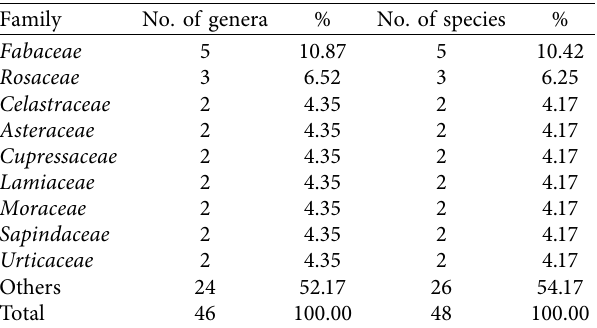
Table 1: Top nine families with the number of genera and species in Zijje Maryam Church Forest.